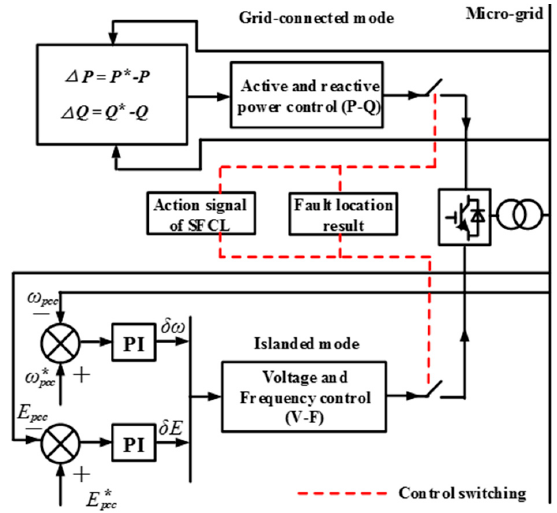
Figure 6. Control mode switching of the battery energy storage (DG3).